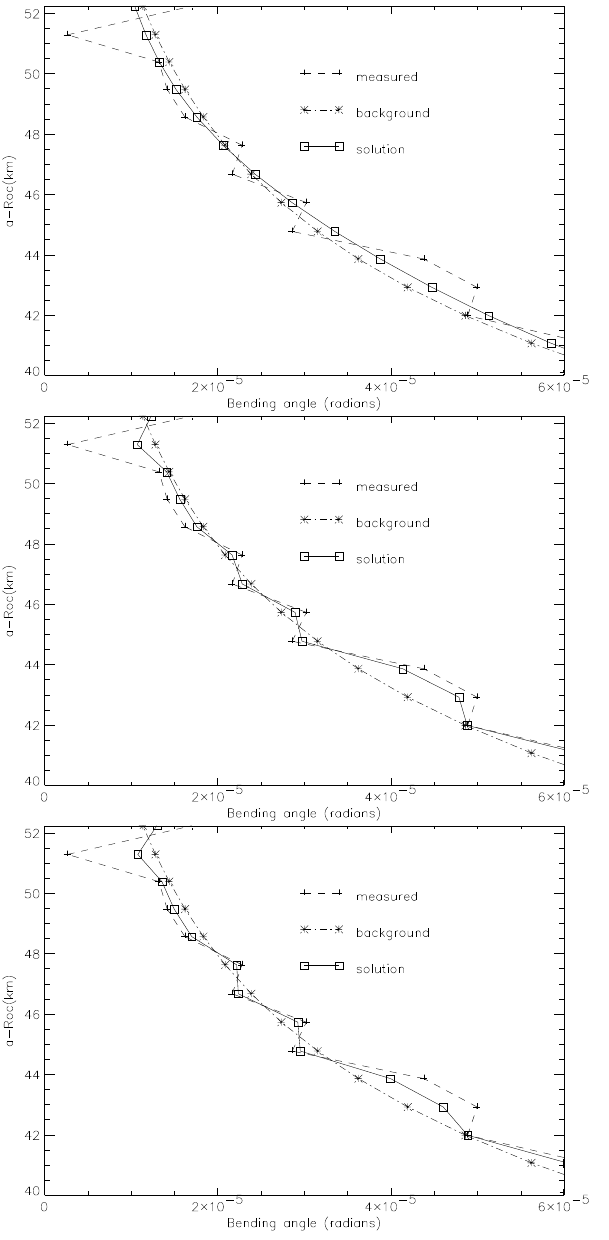
Fig. 2. Illustrating the smoothing of corrected bending angles for JPL profile ‘95-07-01-02:44met-gps15’ using (a) Eq. 6, (b) Eq. 8 and (c) Eq. 9. The vertical axis is ‘impact parameter minus radius of curvature’.